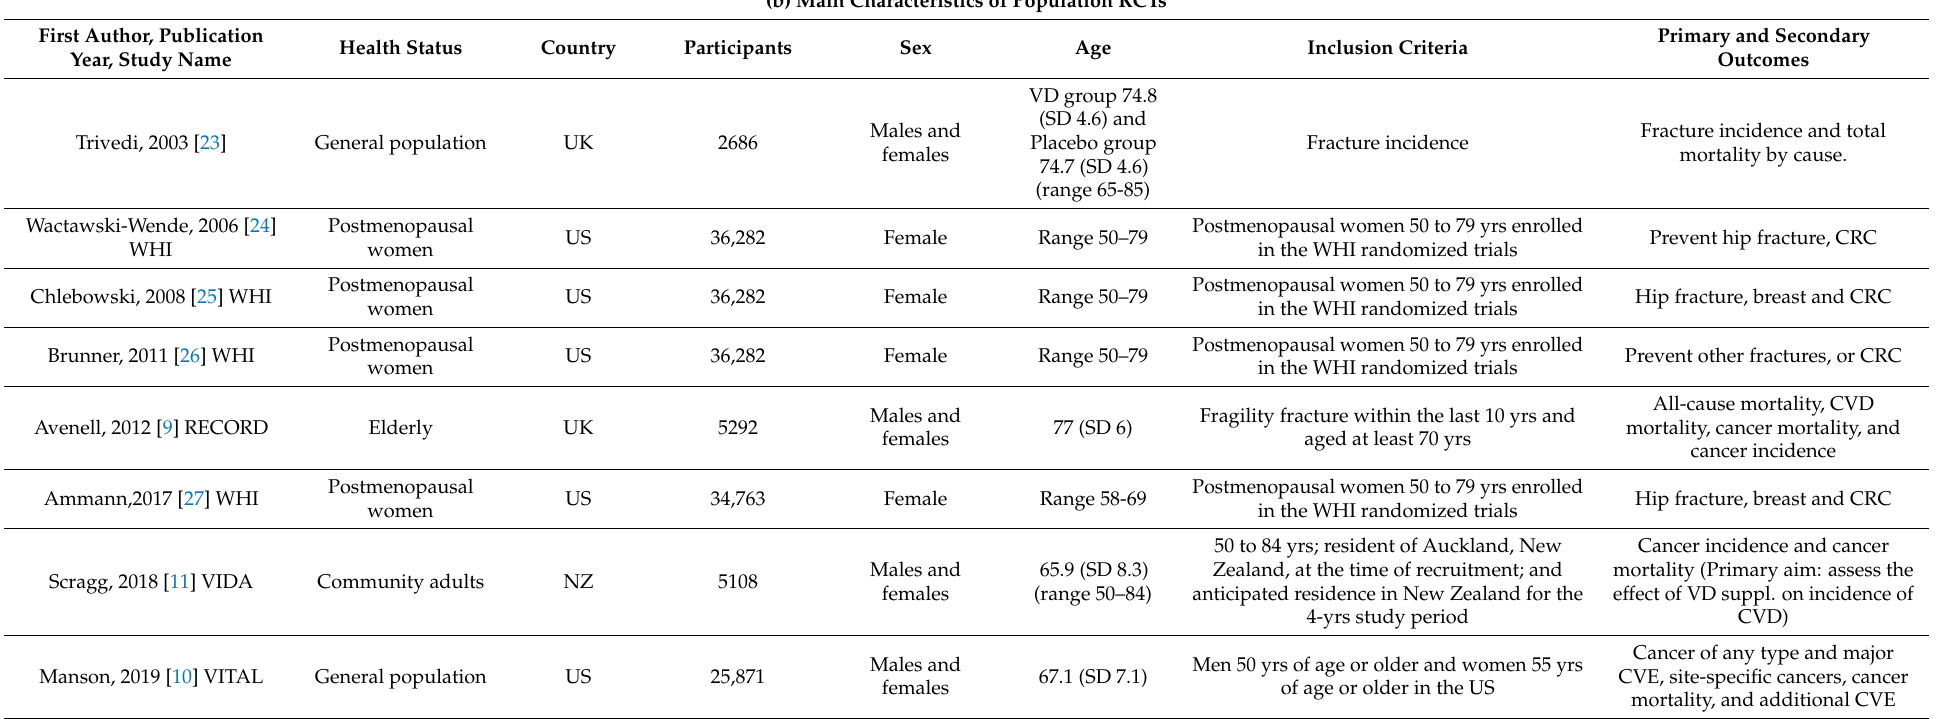
(b) Main Characteristics of Population